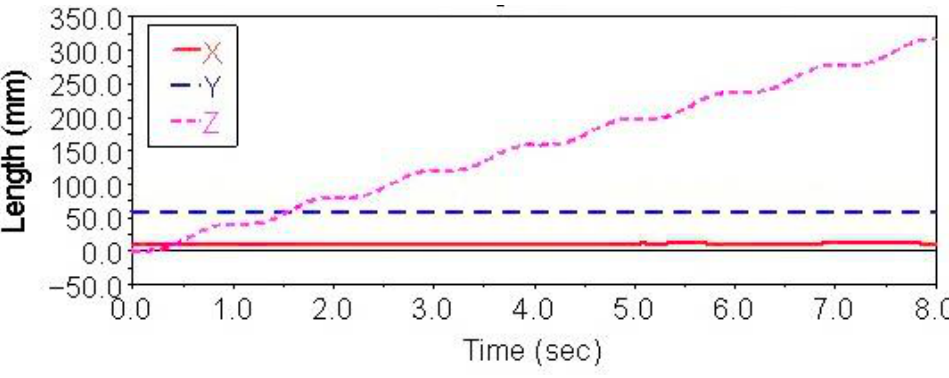
Figure 11. Centroid displacement curve for crossing over obstacles.